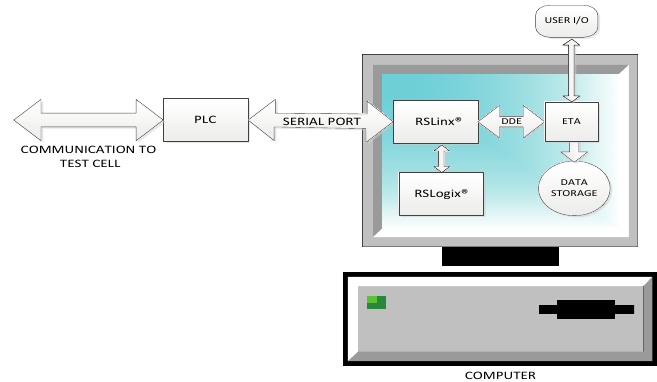
Fig. 1. Mercedes Benz diesel engine: a) photographic, b) schematic.